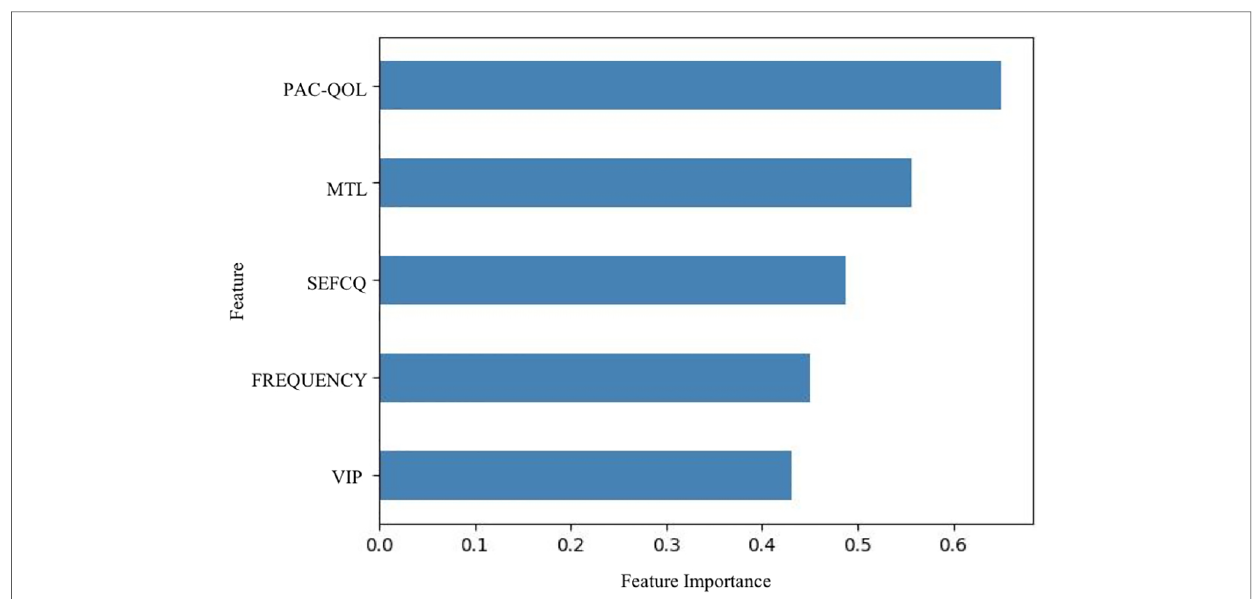
FIGURE 2 Feature importance of variables estimated by selectKBest. The importance of the features were evaluated by SelectKBest. Of the 15 features that were evaluated, these are the top 5 features used in the prediction models, stool frequency, PAC-QOL, SEFCQ, MTL, VIP. FREQUENCY, stool frequency; PAC-QOL, PAC-QOL (Satisfaction); SEFCQ, SEFCQ (Emotion); MTL, motilin; VIP, vasoactive intestinal